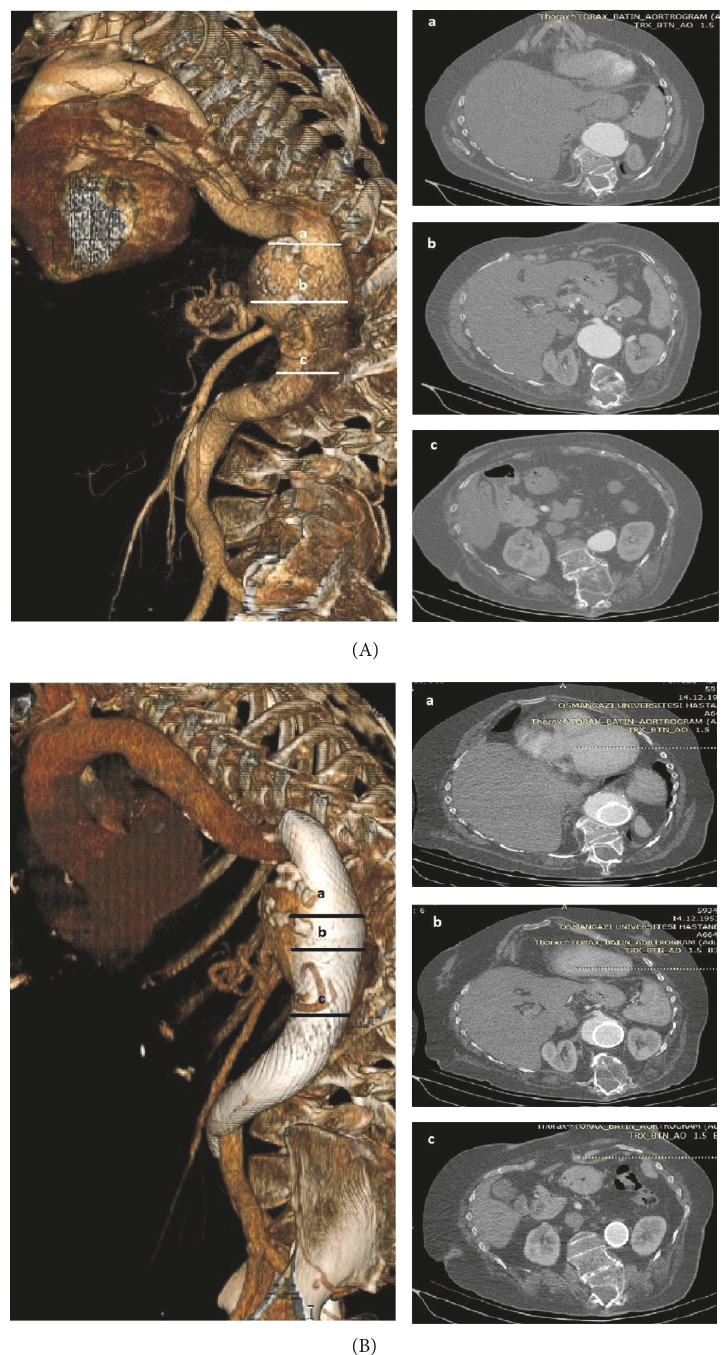
Figure 1: (A) Images of the patient with thoracoabdominal aortic aneurysm. (B) Images of the patient with thoracoabdominal aortic aneurysm after the multilayer flow modulator device